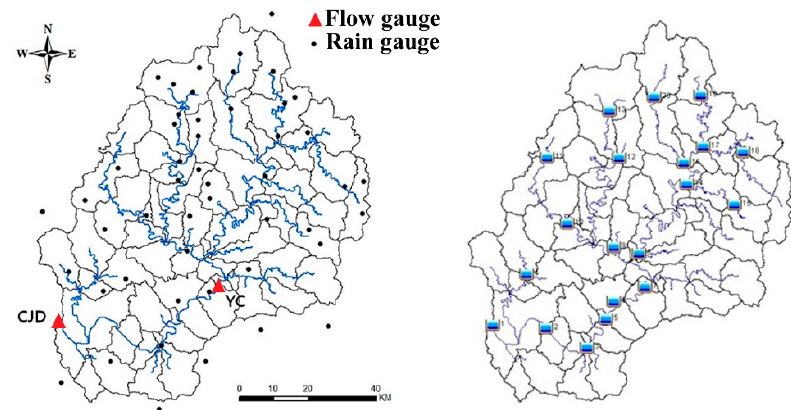
Figure 1. The Chungju dam basin and sites used for the RFFA (left). The divided sub-watershed is based on water resource unit map defined in WAMIS (www.wamis.go.kr).